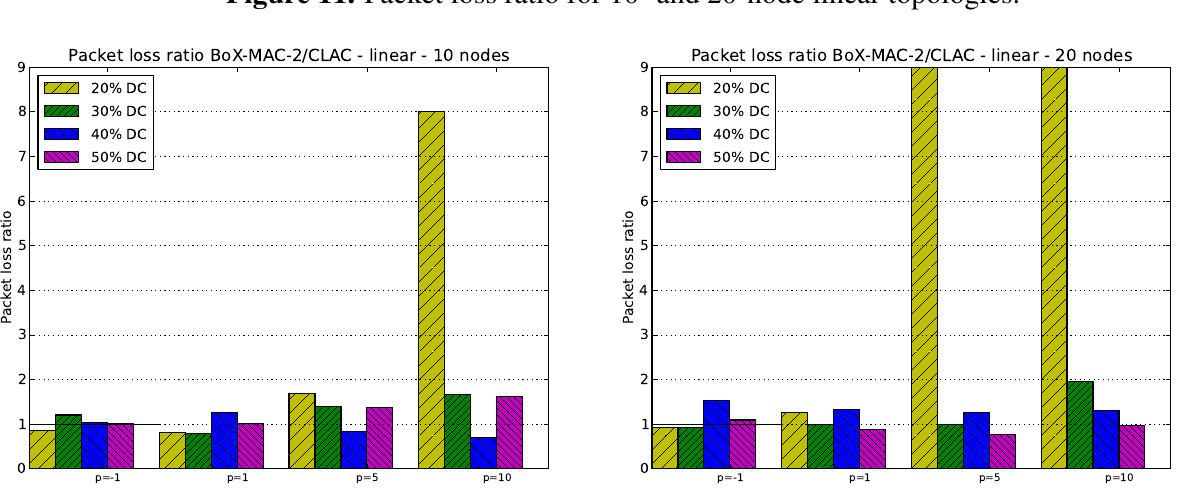
Figure 11. Packet loss ratio for 10- and 20-node linear